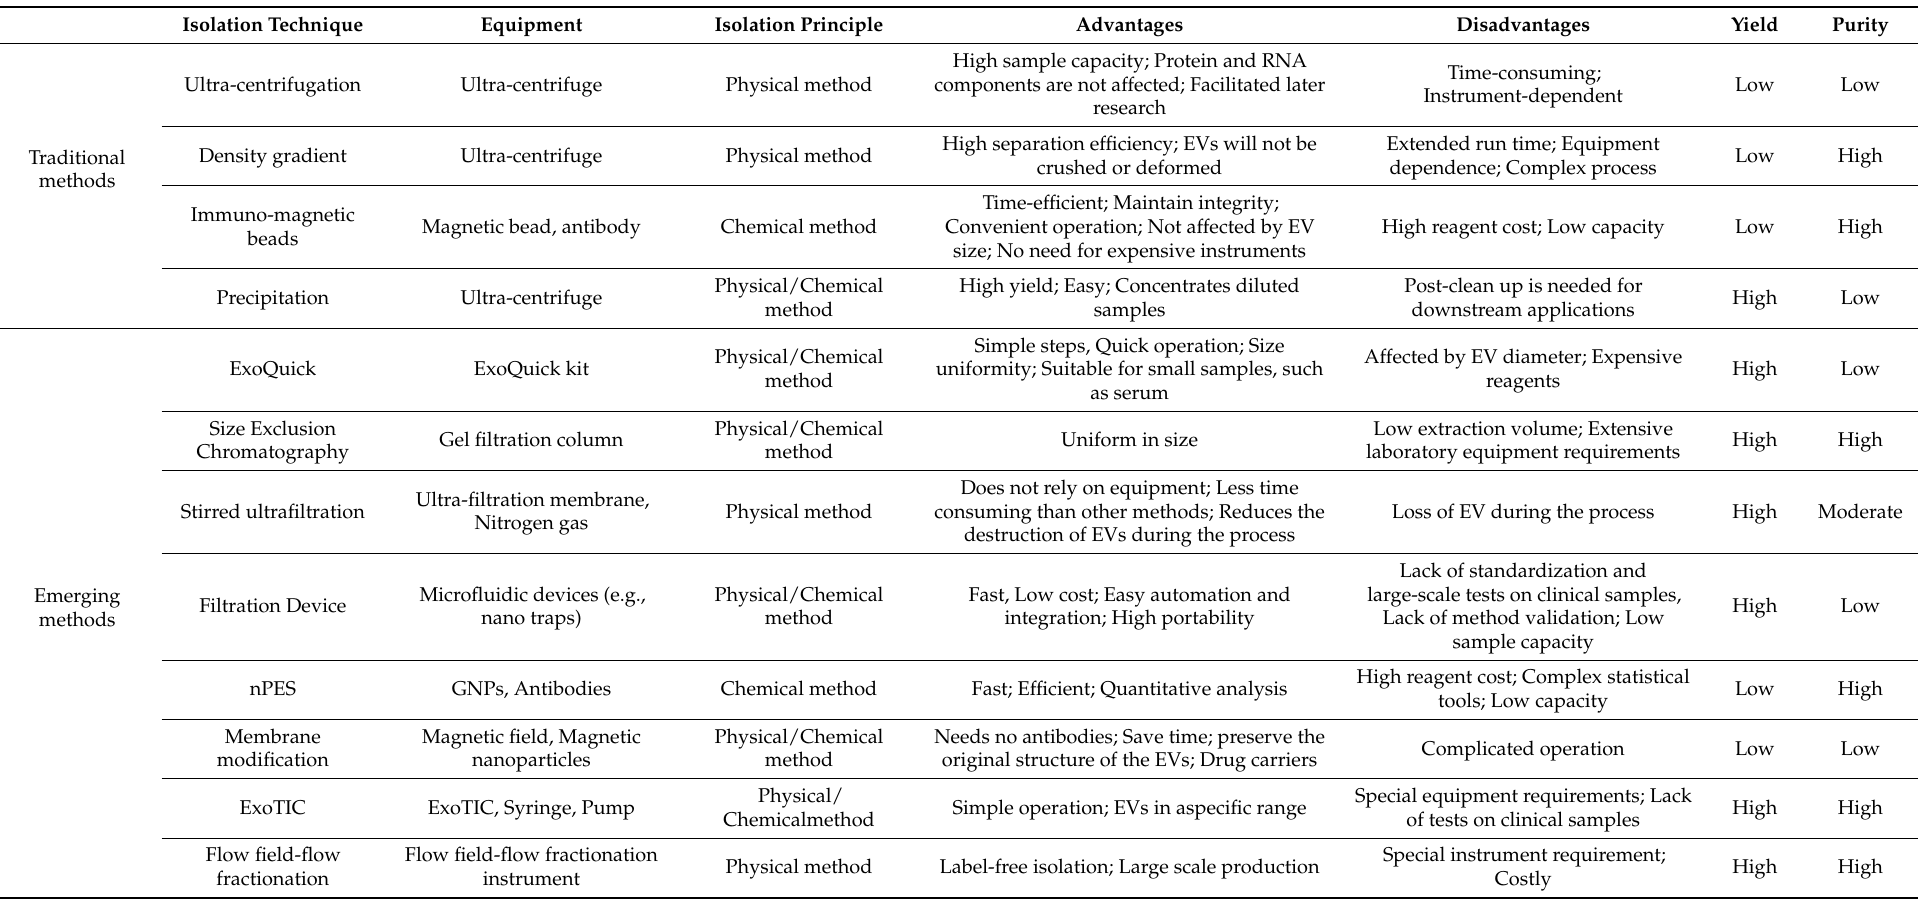
Table 3. Characteristics of EV isolation methods (Adapted from